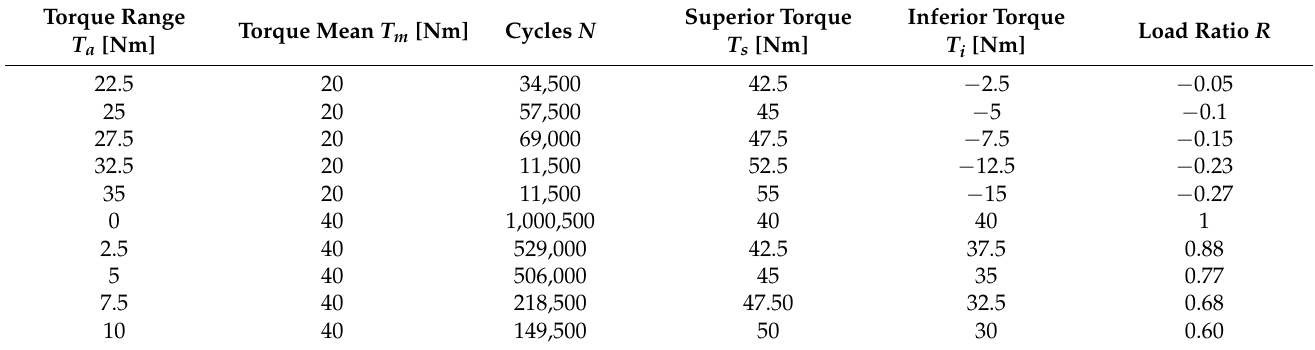
Table 5. First ten load histories from Rainflow method counting (ICE vehicle model).